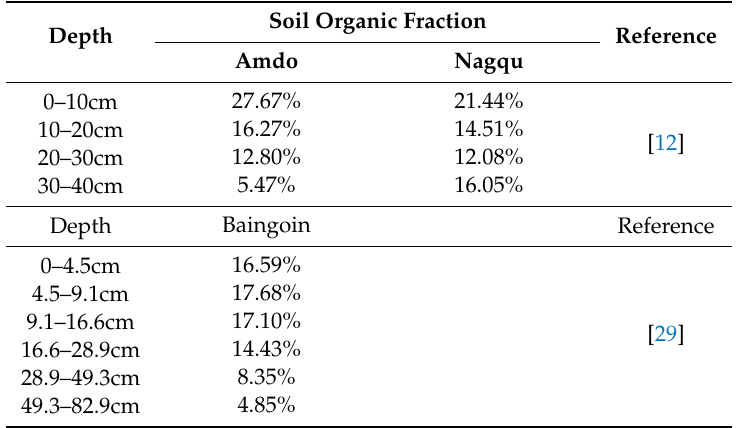
Table 3. Volumetric measurements of soil organic matter at di ff erent depths.